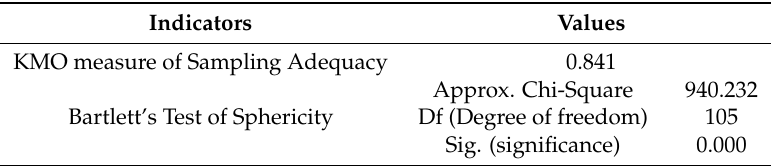
Table 6. Results of Kaiser-Meyer-Olkin (KMO) analysis and Bartlett’s Test of